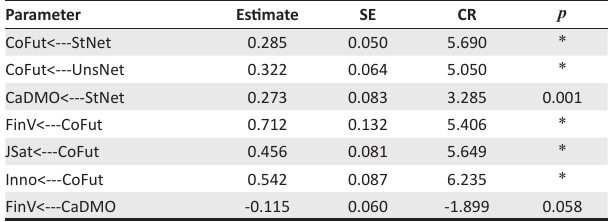
TABLE 5: Parameter estimates with p -values.